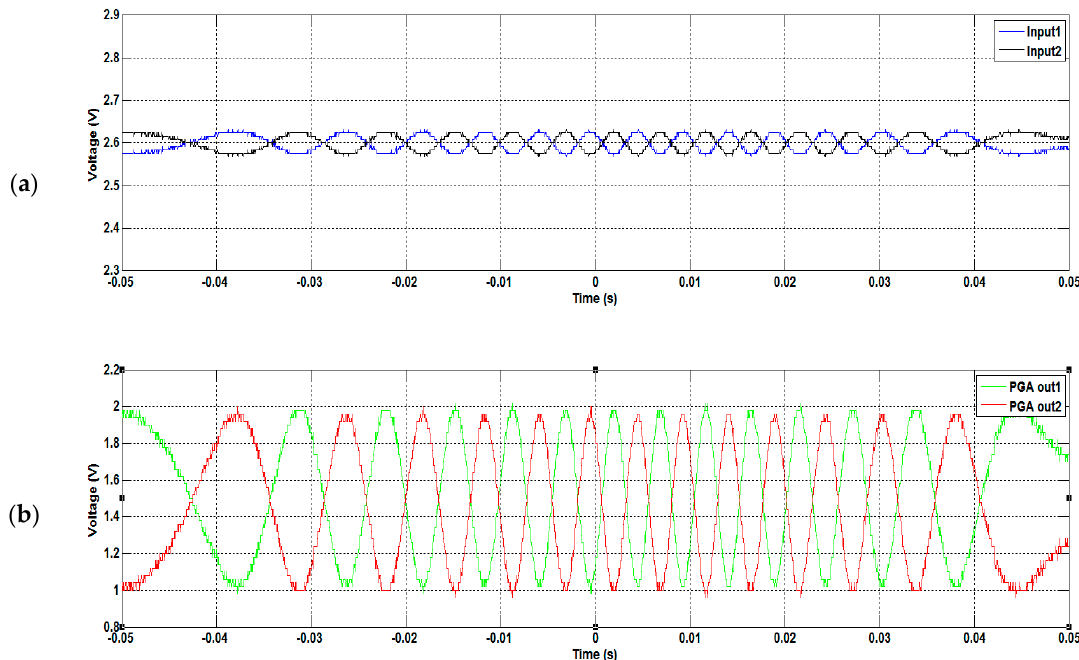
Figure 12. Measured result of the PGA: ( a ) sin/cosine inputs; ( b ) sin/cosine outputs.